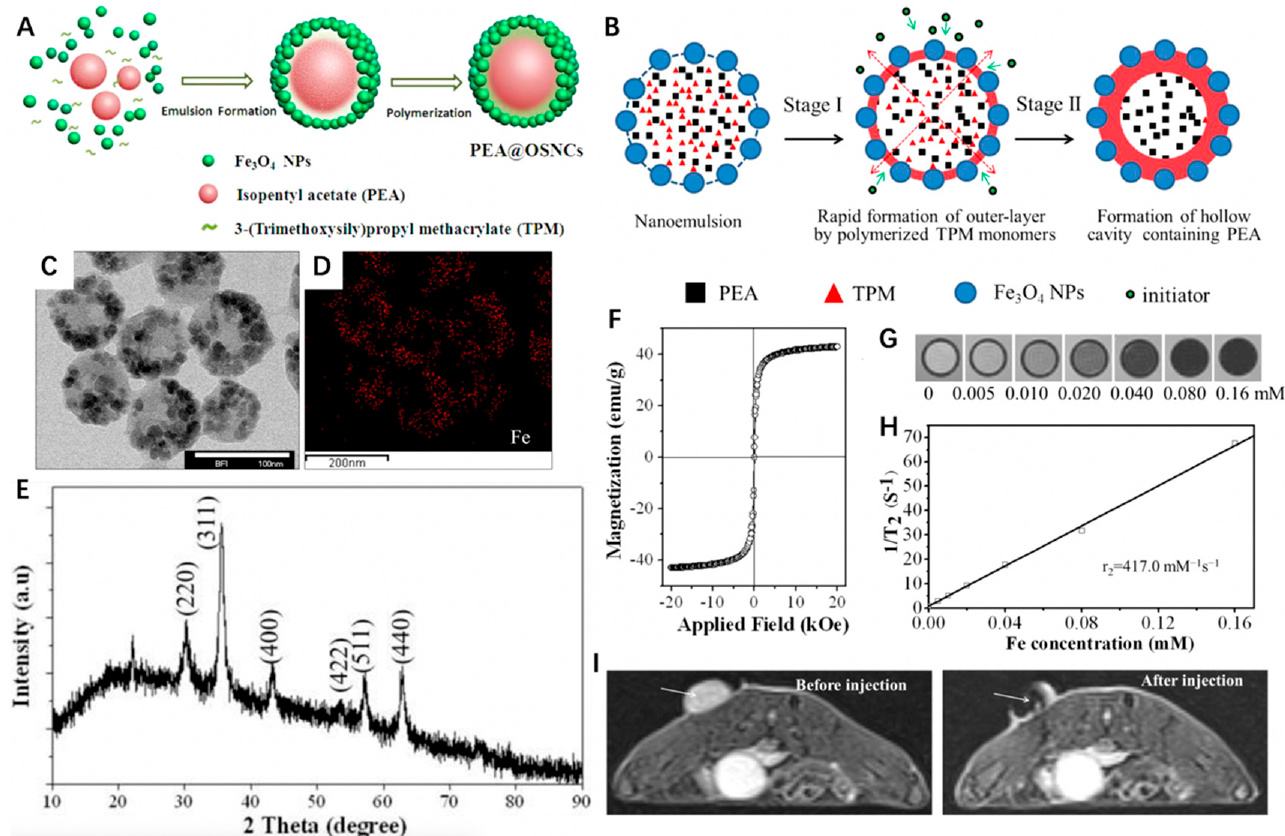
Figure 2. ( A ) Schematic illustration of the synthesis of PeA@OSNC. ( B ) Schematic illustration of the structural conversion process from nanoemulsion to hollow structure. ( C ) TEM images of PeA@OSNC. ( D ) Fe element mapping corresponding to panel B, displaying the distribution of Fe 3 O 4 nanoparticles in the overall structure. ( E ) XRD pattern of PeA@OSNC presents the characteristic diffraction peaks of magnetite (Fe 3 O 4 ) crystals including (220), (311), (400), (511), (422) and (440) lattice planes. ( F ) Field-dependent magnetization curve of OSNC at room temperature. Absence of hysteresis loop confirms the superparamagnetism of our prepared sample. ( G ) T 2 -weighted MR phantom images and ( H ) plot of inverse transverse relationship times (1/T 2 ) versus Fe concentration for OSNC. ( I ) In vivo MR imaging of tumor-bearing mice before and after intratumoral injection of PeA@OSNC suspension. Arrows point to tumor tissue. Reprinted with permission from Ref. [78]. Copyright 2016, American Chemical Society. 2.2. Dual-Modal Imaging Nevertheless, T 1 - or T 2 -weighted MRI alone cannot achieve accurate clinical diagno- sis, multi-modal imaging has become a research hotspot over the past decade as it can combine the advantages of each imaging method [26]. By combing two kinds of magnetic cores, T 1 -T 2 dual-modal MRI with exceptional accuracy and reliable manner has received considerable attention over the past years [79,80] (Scheme 2).